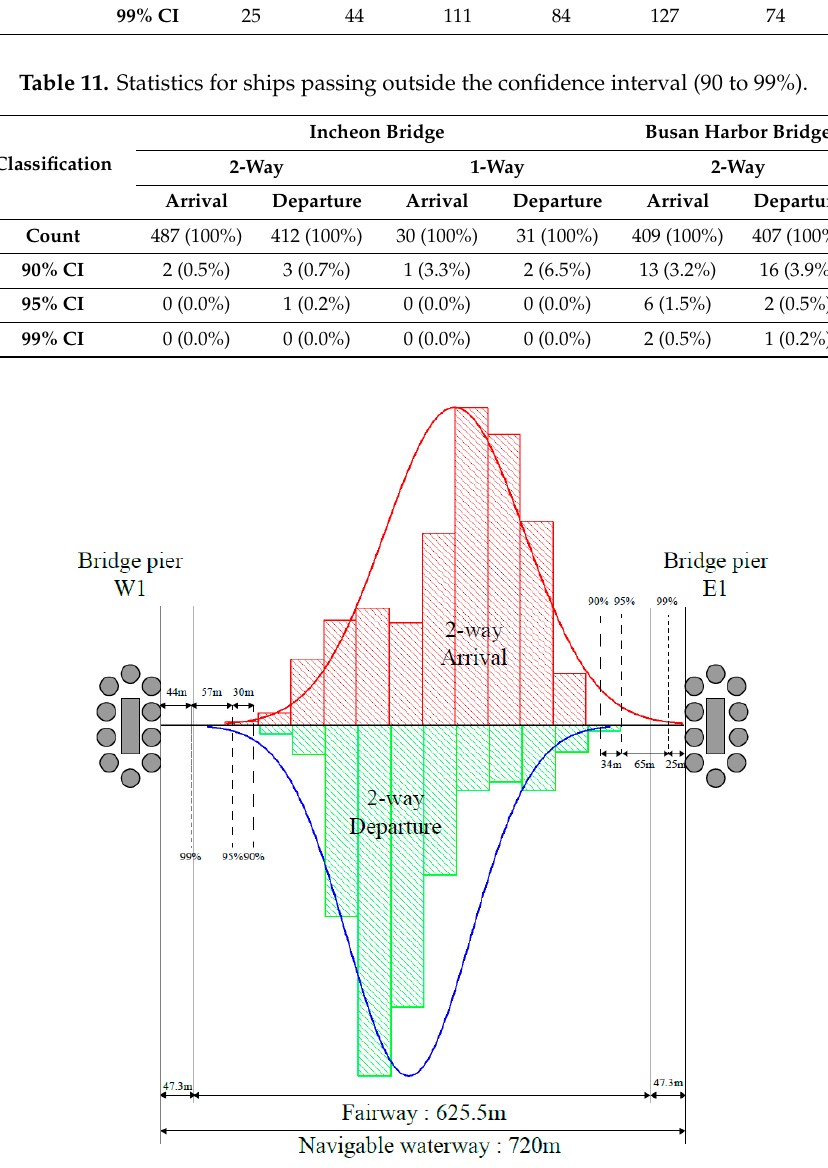
Figure 12. Traffic distribution at the Incheon bridge for 2-way traffic. Figure 12. Tra ffi c distribution at the Incheon bridge for 2-way tra ffi